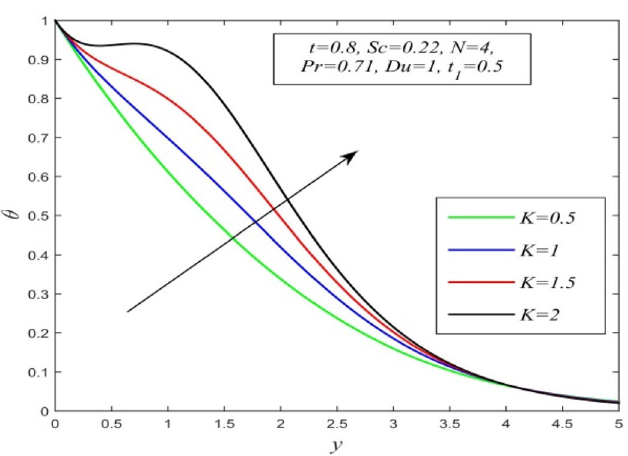
Figure 6. θ versus y for different K and t = 0.8, Sc = 0.22, N = 4, Pr = 0.71, Du = 1, t 1 =